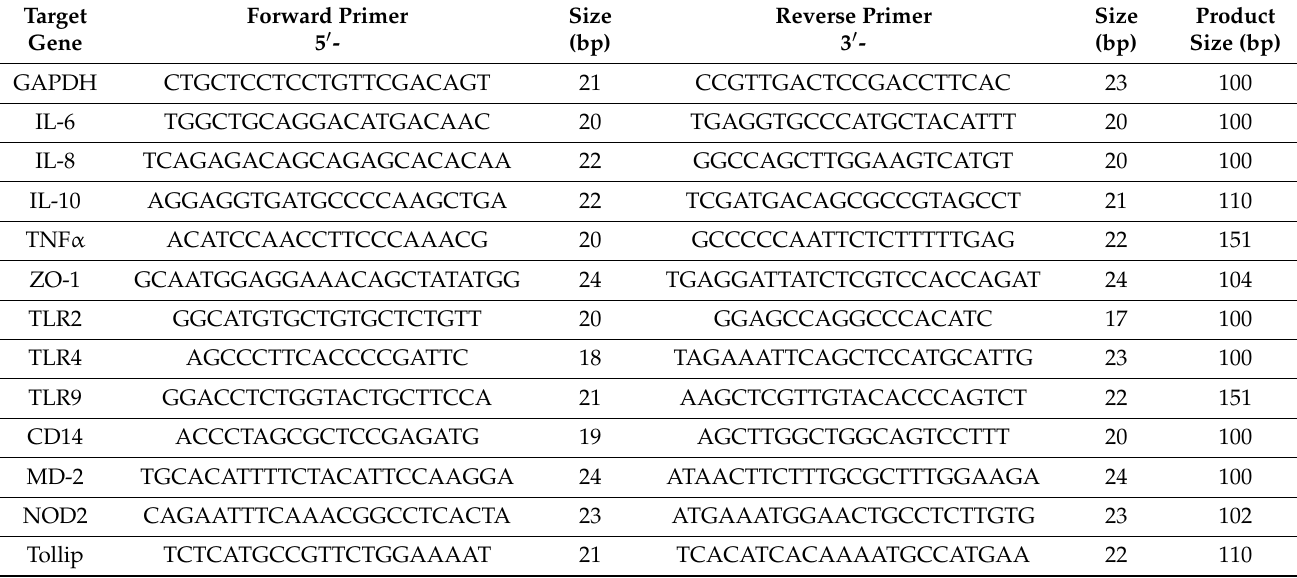
Table 1. Sequence of Real Time-PCR primers and estimated product